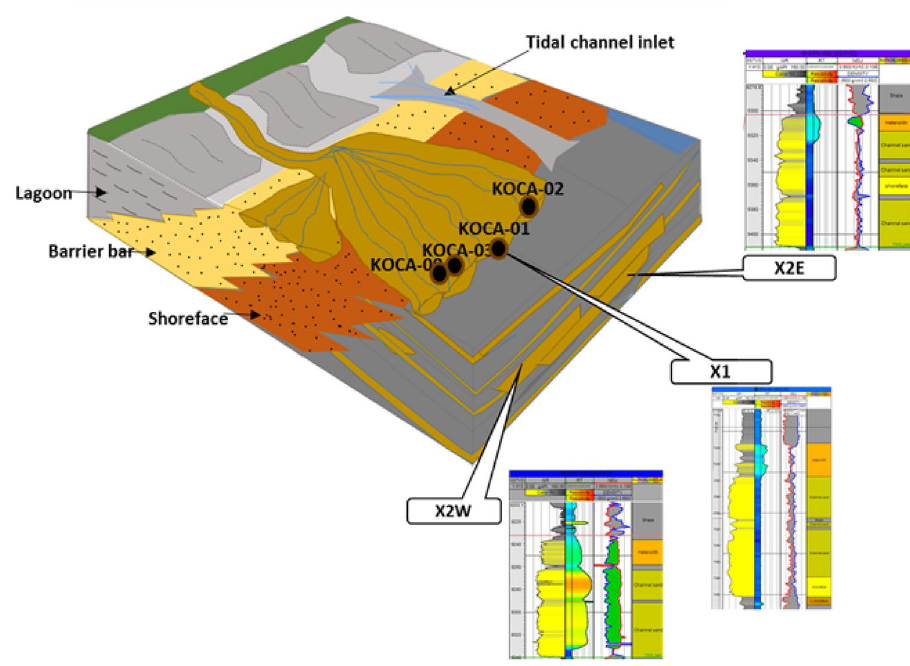
Fig. 12 Conceptual depositional model showing a channelized shoreface